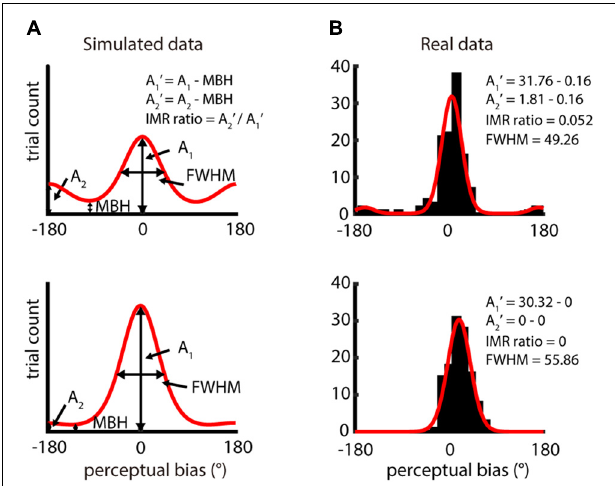
FIGURE 2 | Analysis of IMR from distribution of perceptual bias – difference between perceived direction and veridical direction. (A) Two simulation distributions of perceptual bias generated by bimodal von Mises function. A 1 and A 2 reflect the amplitude of the highest peak and the opposite direction of the highest peak, respectively. A 1 (cid:48) and A 2 (cid:48) were computed by subtracting A 1 and A 2 with the minimal bin height (MBH) and IMR ratio = A 2 (cid:48) /A 1 (cid:48) . Data in the upper panel show obvious IMR, but data in the lower panel show weak IMR. (B) Single-participant responses from two different spatio-temporal conditions (upper panel: spatial period = 2 mm, speed = 80 mm/s; lower panel: spatial period = 4 mm, speed = 80 mm/s). The red curve is the bimodal von Mises fit for the binned perceptual bias (bin size = 15 ◦ ). Results in the upper and lower panels had higher (IMR ratio = 0.052) and lower IMR (IMR ratio = 0), respectively.